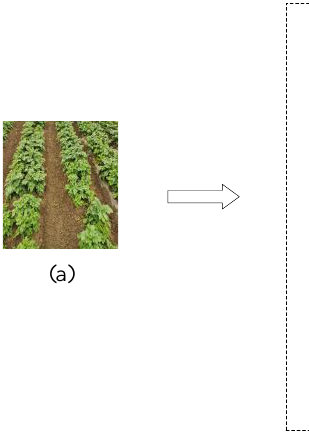
Figure 6. Data augmentation: ( a ) original image; ( b ) counterclockwise rotation 45°; ( c ) clockwise rotation 45°; ( d ) horizontal mirror; ( e ) vertical mirror; ( f ) brightness adjustment; ( g ) contrast adjustment.